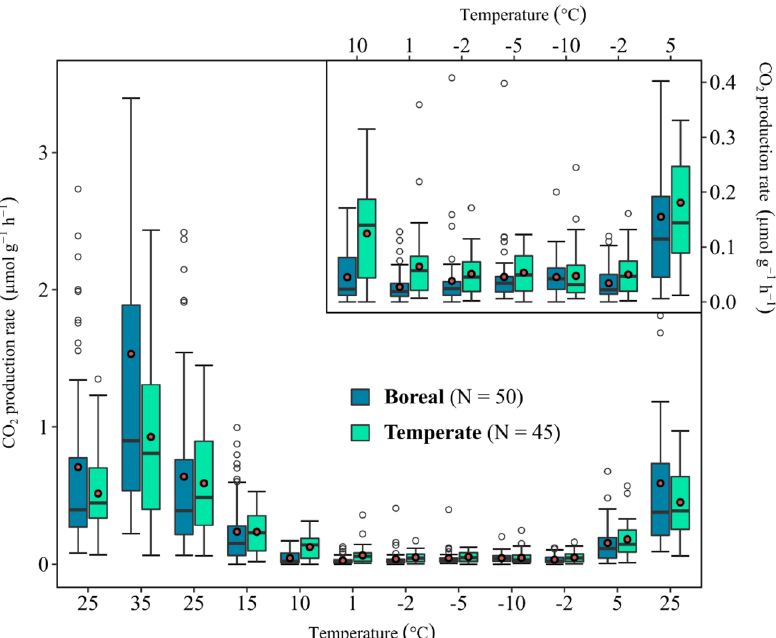
Figure 4. Boxplots of the peat CO 2 production rates for the 12 incubation temperature settings grouped by ecoclimate (N represents the number of data points). The incubation temperature changed in sequential order from the first 25 °C to the last 25 °C, from left to right along the x-axis. The inset plot zooms into the results for the low temperature range (≤ 10